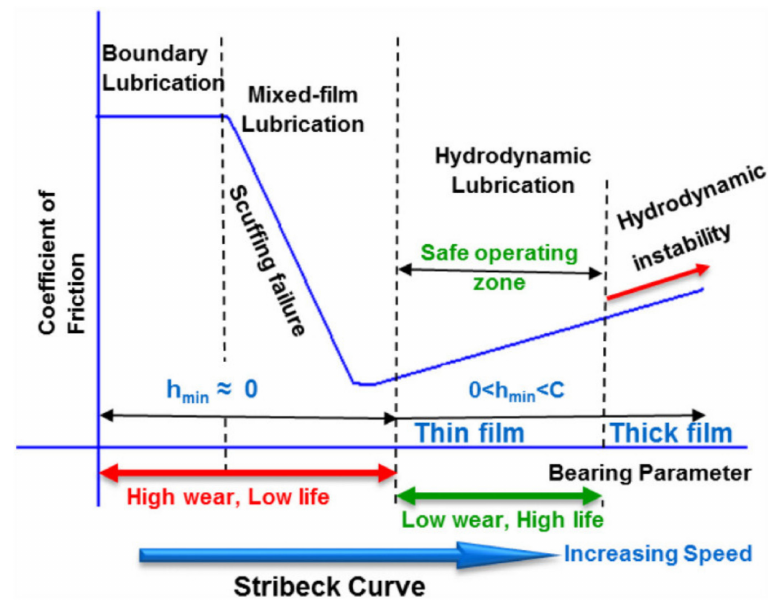
Figure 5. Summary of different lubrication regimes, with possible failures